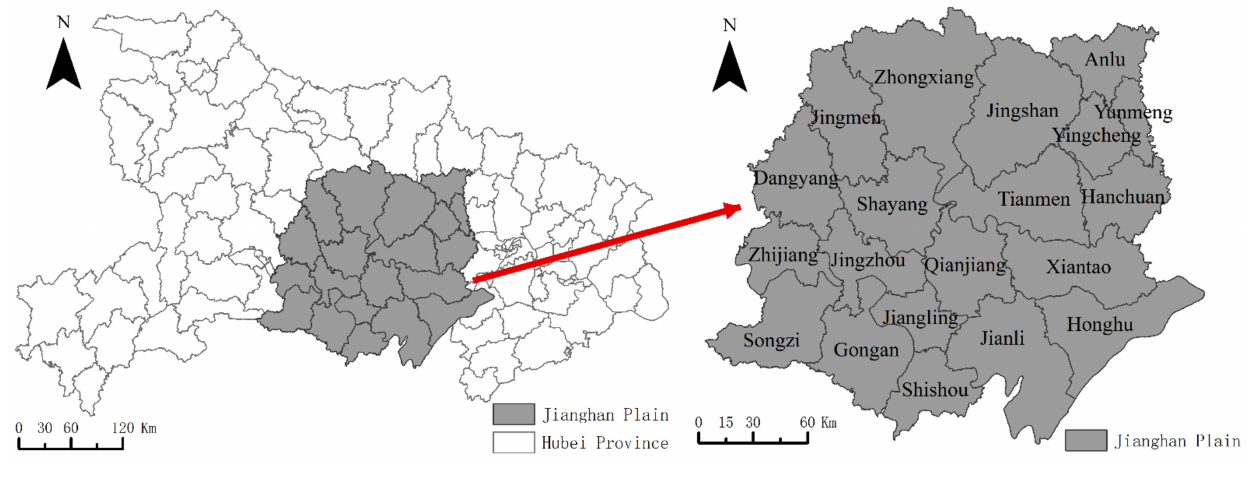
Figure 1. Location of the study